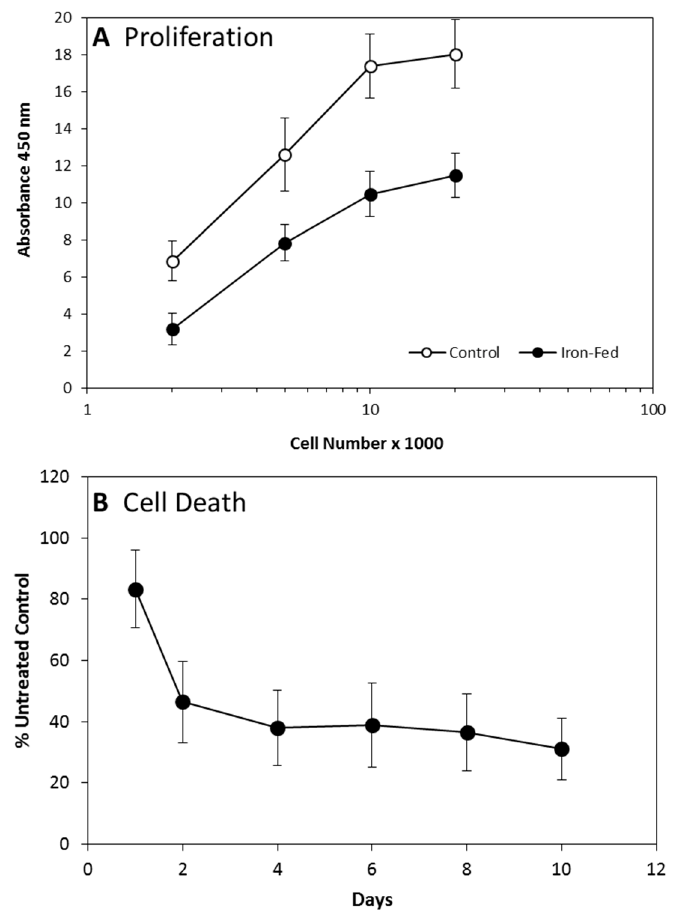
Figure 3. Proliferation and Cell Death ( A ) The rate of proliferation of C8B4 microglia was assessed using a bromodeoxyuridine (BrdU) based ELISA kit. Both control and iron-fed microglia were plated into a 96 well plate at a range of densities and grown overnight. BrdU was then added for a further 16 h before the ELISA assay was used to assess incorporation levels. The level of incorporation was assessed by a colorimetric assay with a read out at 450 nm. Iron-fed microglia showed significantly lower levels of proliferation at all plating densities other than the highest ( p < 0.05). Shown are the mean and S.E.M. of four separate experiments. ( B ) The level of cell death in C8B4 cells was assessed during their initial treatment with 500 μ M ferric ammonium citrate. C8B4 cells were plated in 24-well trays at low density (20% confluency). The cells were then treated with iron for up to 10 days. The level of cell death was assessed using a commercial ELISA kit that determines the levels of histone associated DNA fragments in the cytoplasmic fraction. The results showed a significantly lower level of cell death in cells treated with iron for 2–10 days ( p < 0.05). Only cells treated for one day showed no significant difference to the untreated cells ( p > 0.05). Shown are the mean and S.E.M. of four separate experiments.